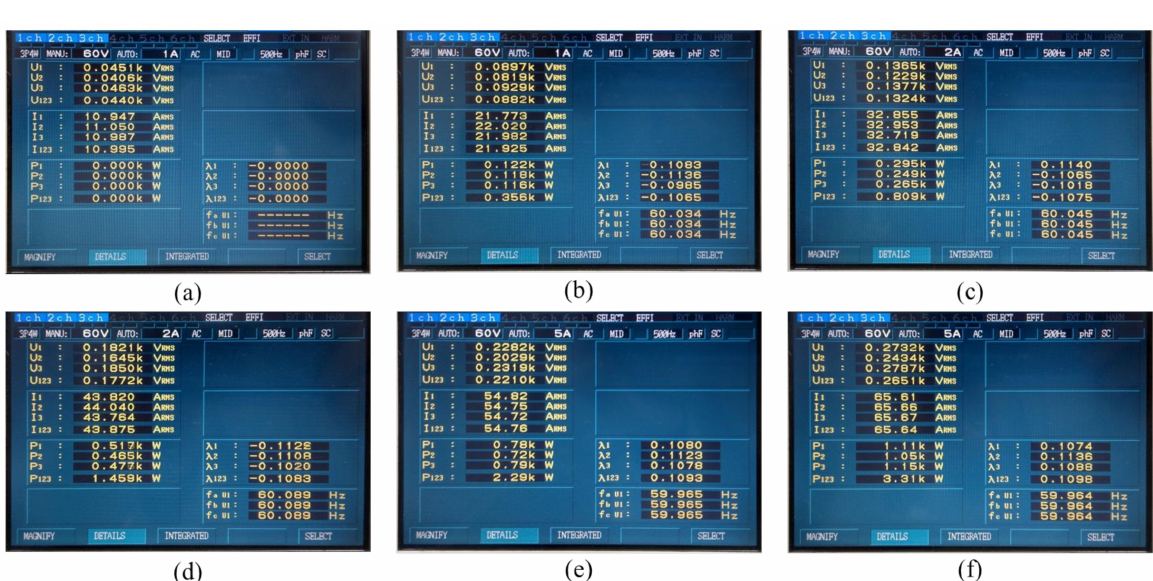
Figure 21. The fault trace of this case.